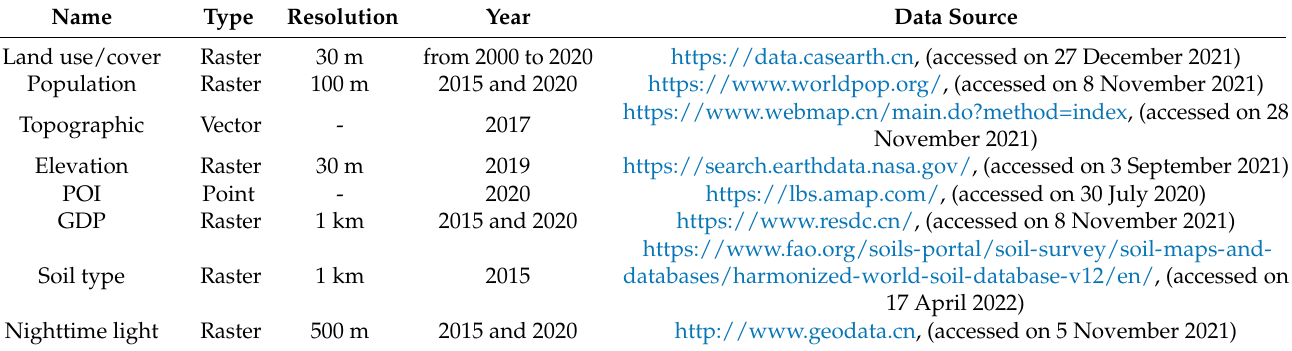
Figure 1. Location of the Chongqing metropolitan area. Table 1. Research